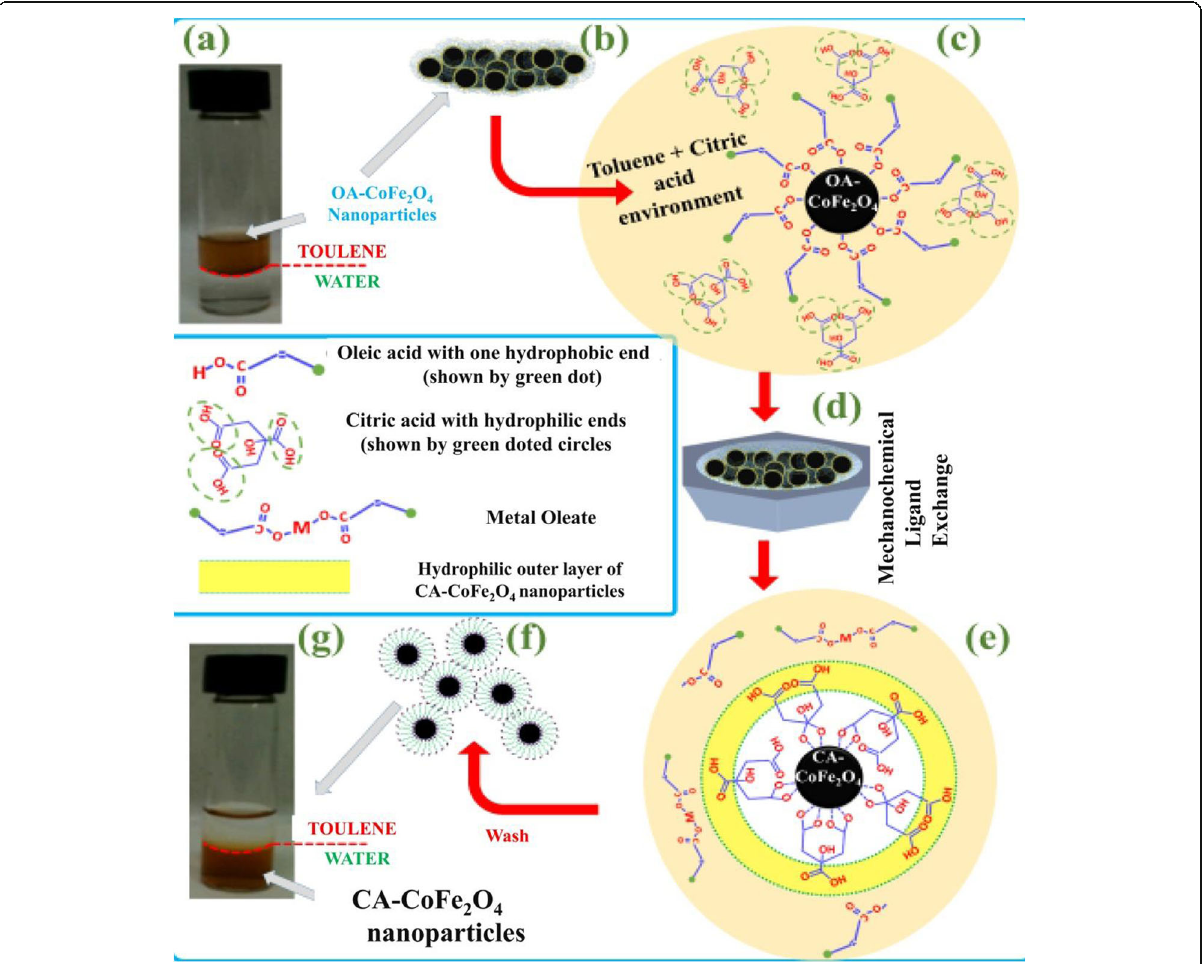
Fig. 9 Schematic presentation of synthesis of CA-coated CoFe 2 O 4 NPs. The OA-CoFe 2 O 4 -NPs in water and toluene a ; OA-CoFe 2 O 4 -NPs b ; OA- CoFe 2 O 4 -NPs in CA and toluene c ; liquid-based mechanical grinding of OA-CoFe 2 O 4 -NPs d ; CA coated CoFe 2 O 4 -NPs e ; CA-Fe 2 O 4 -NPs f ; CA-Fe 2 O 4 - NPs in water and toluene f . [ “ Reprinted (adapted) with permission from [36]. Copyright 2018 Elsevier. ”